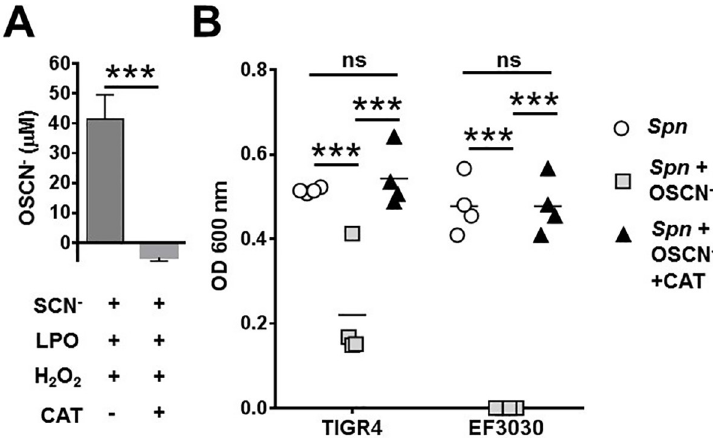
Fig 2. Catalase rescues Spn from OSCN — mediated growth inhibition. (A) Addition of catalase to the cell-free system blocks OSCN - generation measured by the DTNB assay. Error bars represent standard errors of the means, n = 4. Mann-Whitney test. (B) Catalase inhibits the bacteriostatic effect of OSCN - on TIGR4 and EF3030 Spn strains (n = 4). Each symbol represents a separate, individual experiment and their mean is also shown, Two-way ANOVA, Tukey’s multiple comparison test. Each experiment was done in biological triplicates and each biological replicate was tested in technical triplicates. Ns, not significant; � , p < 0.05; �� , p < 0.01; ��� , p < 0.001. CAT, catalase.